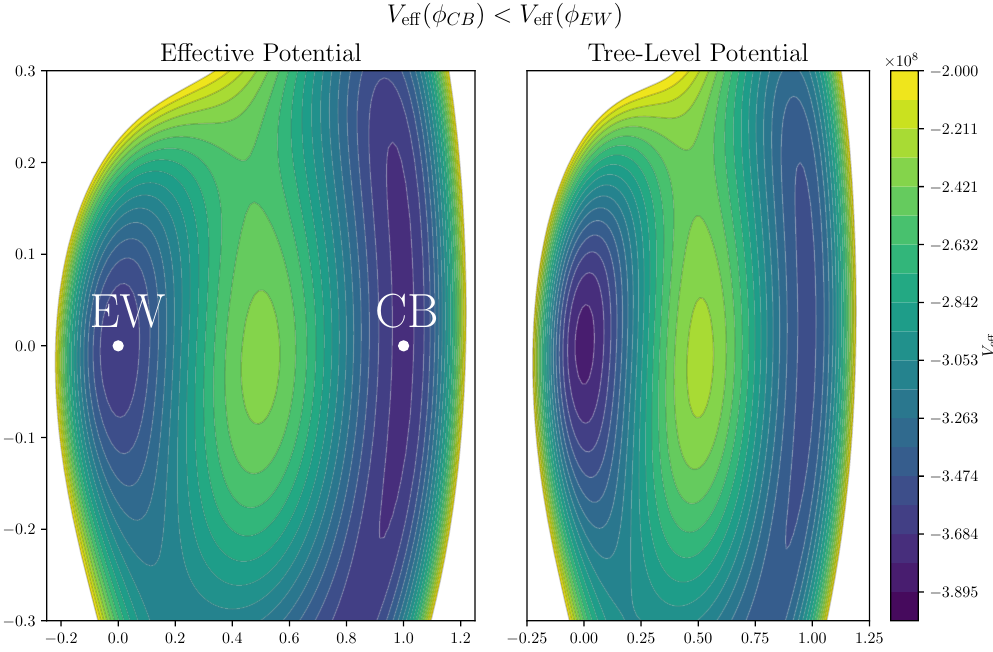
Figure 2. A two-dimensional slice of the e(cid:11)ective potential (left) and the corresponding tree-level potential (right) for the case where V e(cid:11) ( (cid:30) CB ) < V e(cid:11) ( (cid:30) EW ). The horizontal axis is identical to that of (cid:12)gure 1. The vertical axis is an line in r 1 r 2 c 1 space orthogonal to the t -axis, i.e. orthogonal to (cid:0) (cid:0) a line connecting ~(cid:30) EW and ~(cid:30) CB . The scale of s vertical axis is identical to the scale of the horizontal axis, i.e. distance in (cid:12)eld space from ( t = 0 ; s = 0) and ( t = 1 ; s = 0) is identical to the distance in (cid:12)eld space between ( t = 0 ; s = 0) and ( t = 0 ; s = 1) (both these distances are the distances between ~(cid:30) ~(cid:30) CB EW and